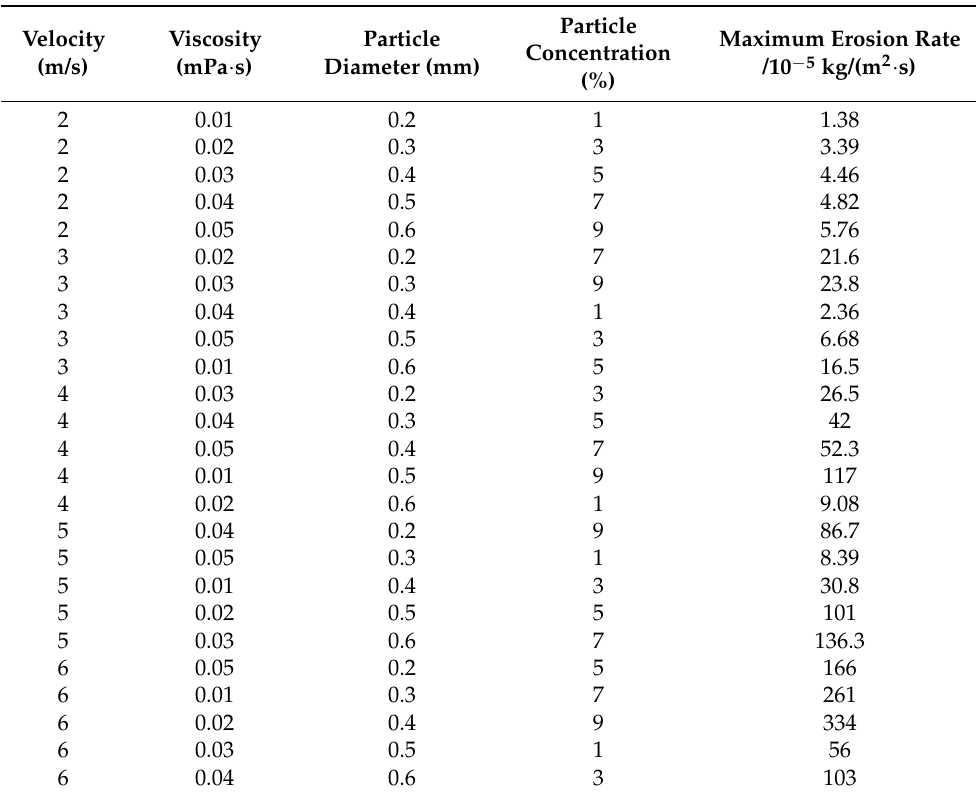
Table 2. Orthogonal test scheme.